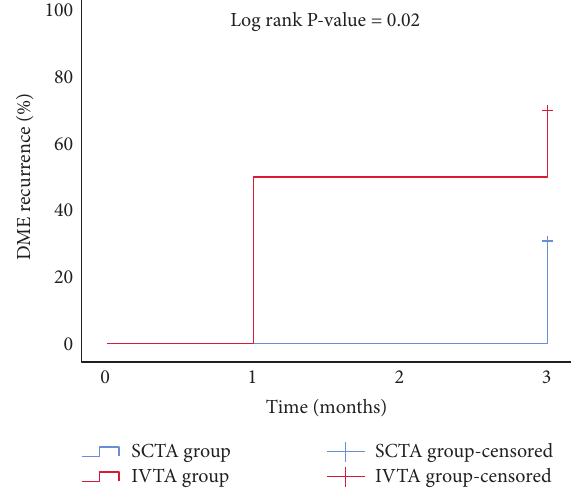
Figure 5: Kaplan–Meier analysis for time to DME recurrence in both groups.